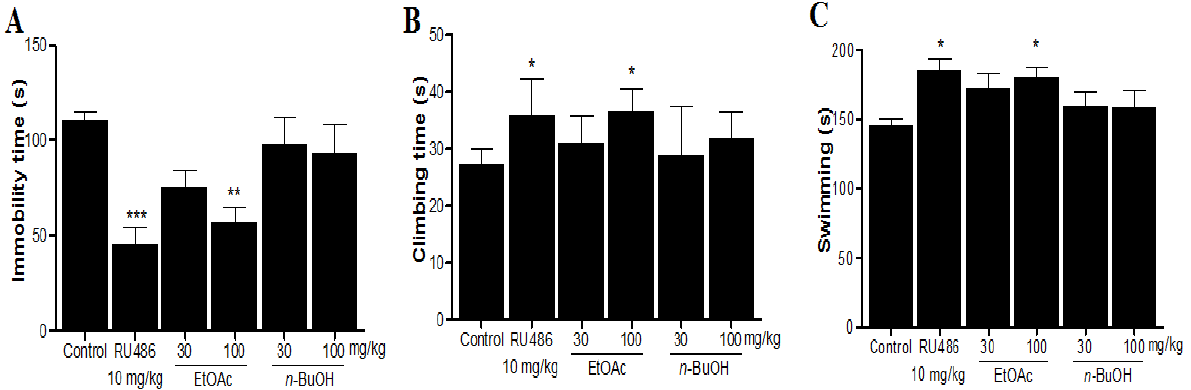
Figure 1. Antidepressant-like effects of treatments with M. alba fractions on depressive behavior in response to the FST. M. alba fractions were given once daily for 7 days. 1 h after the last treatment, rats was exposed to the FST. Immobility ( A ); climbing ( B ); and swimming ( C ) were recorded during the last 5 min in the FST. All data are mean ± SEM values ( n = 8 per group). * p < 0.05, ** p < 0.01, and *** p < 0.001 significantly different from control group.